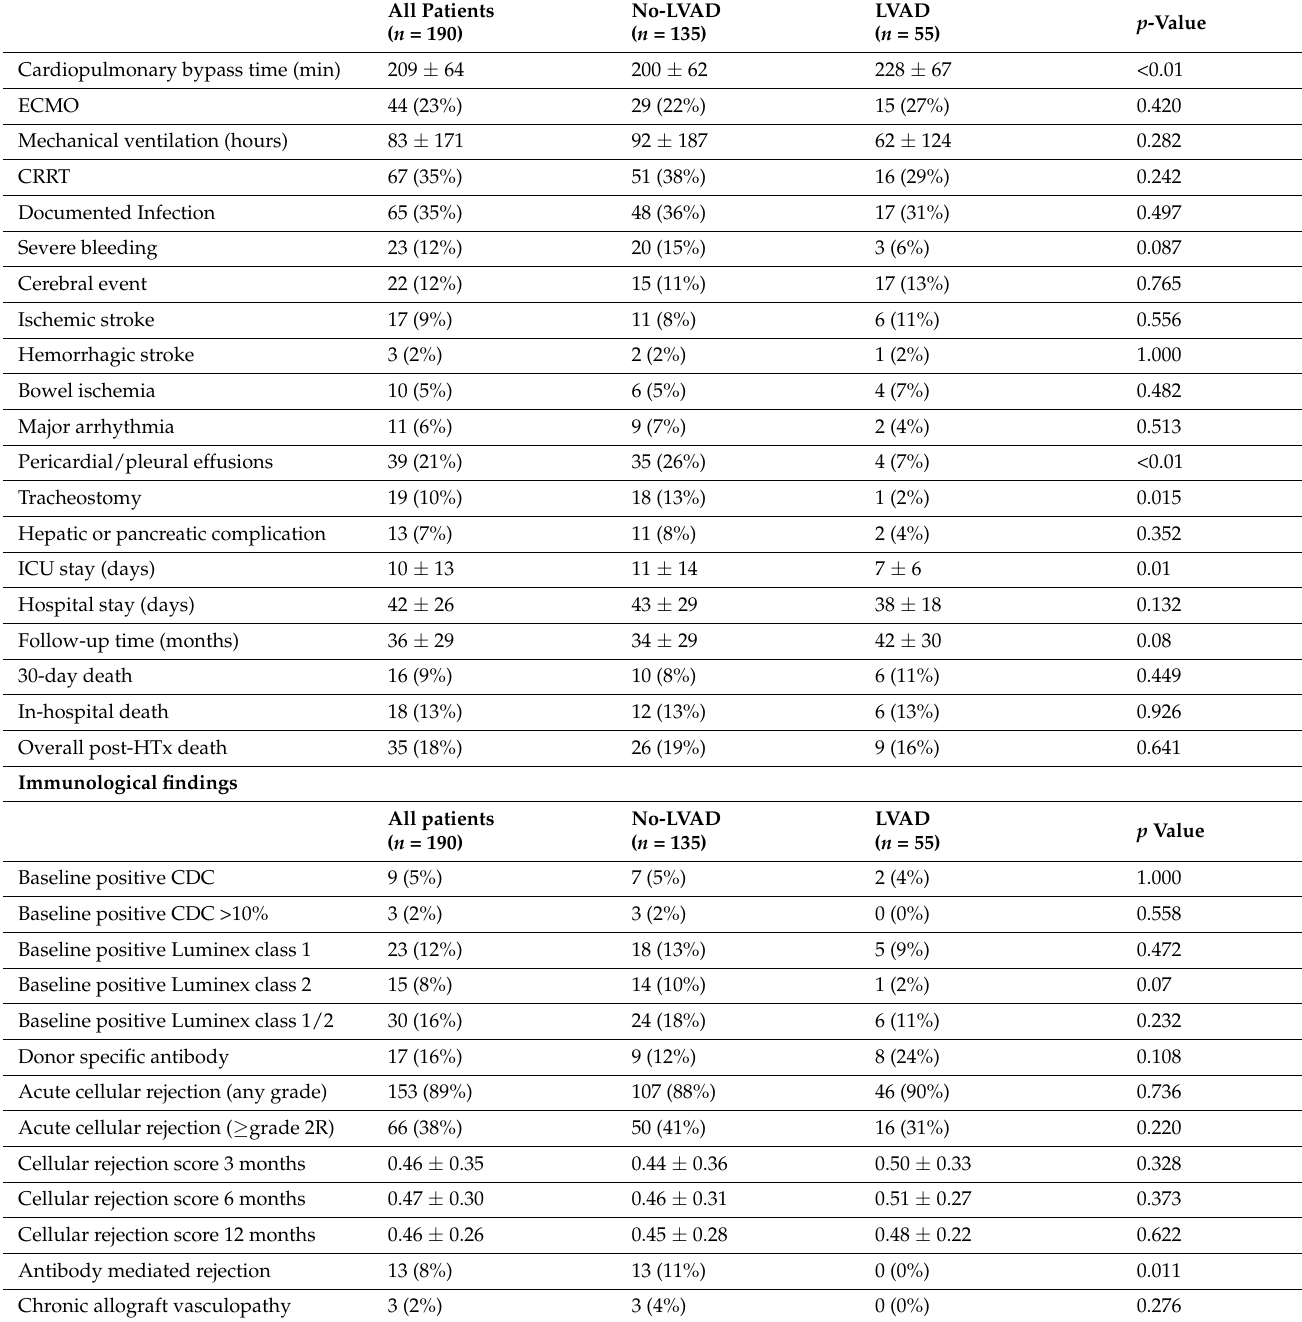
Table 3. Outcomes after